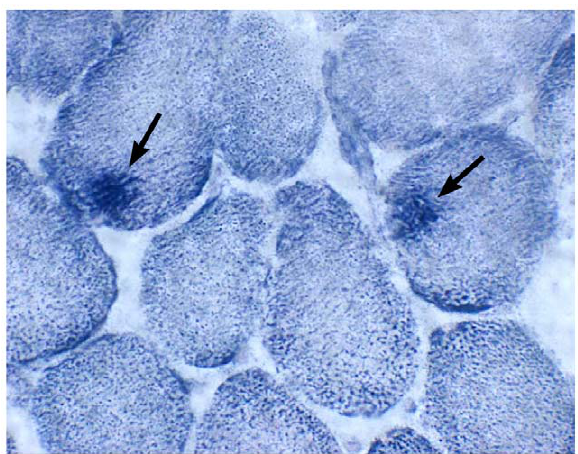
Figure 3. Frozen muscle section from dog # 2, histochemically stained with succinic dehydrogenase (SDH). There are areas of excessive SDH positive staining (arrow) in two myofibers, most consistent with mild mitochondrial proliferation.